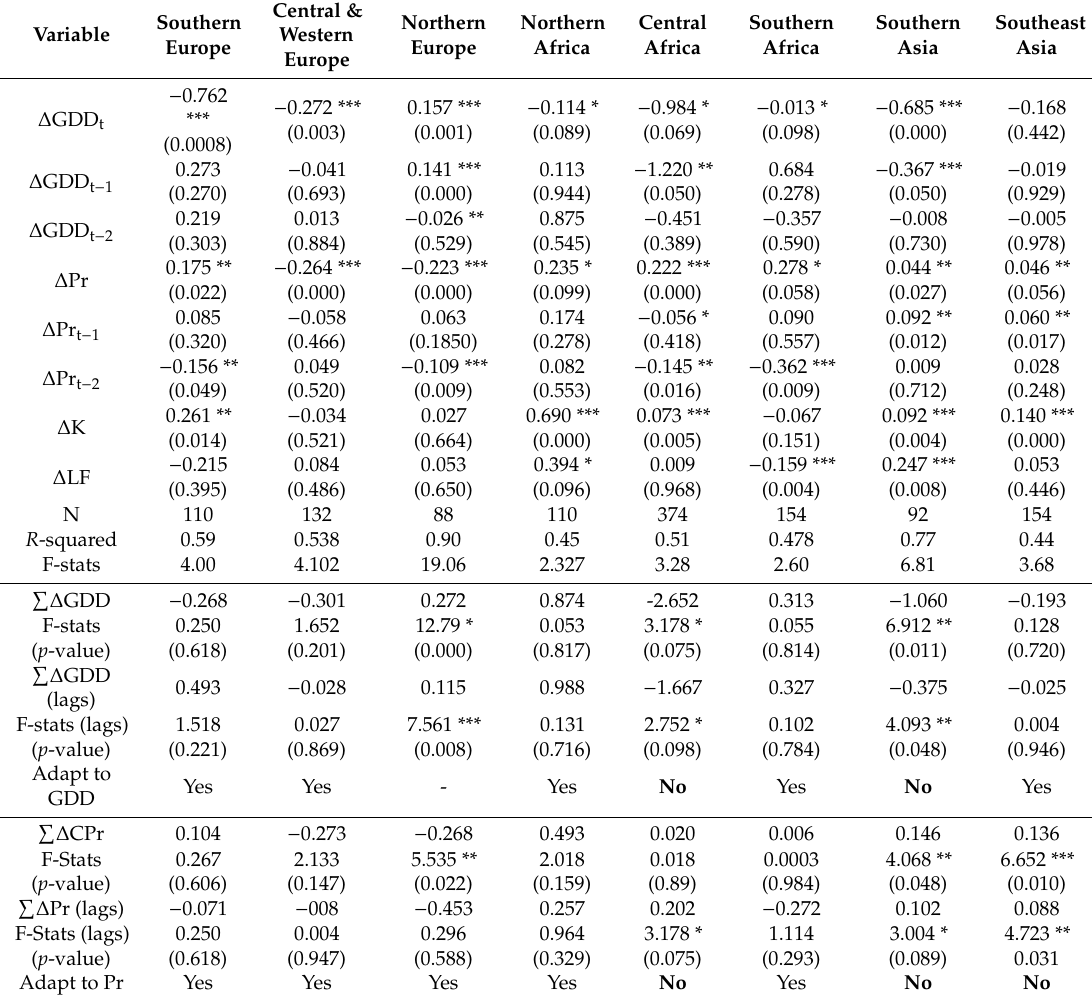
Table 2. Climate change and